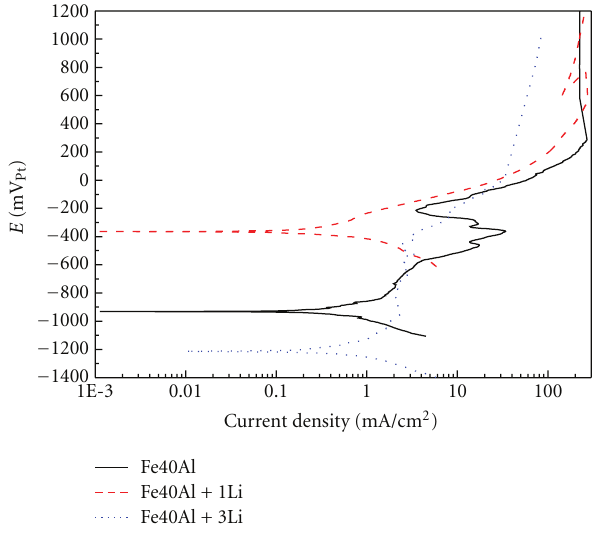
Figure 5: E ff ect of Li on the polarization curve for Fe40Al alloy in NaCl-KCl (1:1 molar ratio) salt in static air at 670 ◦ C.